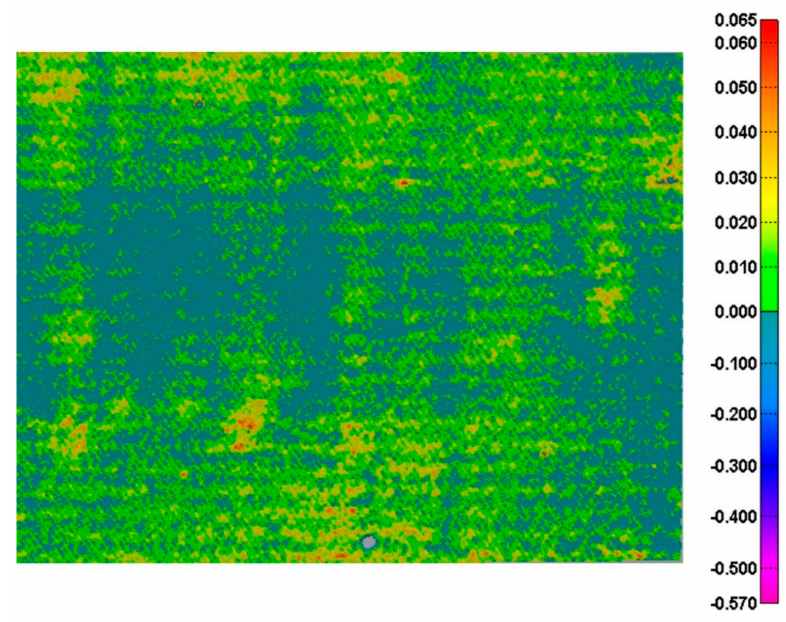
Figure 15. Plane fitting deviation color map